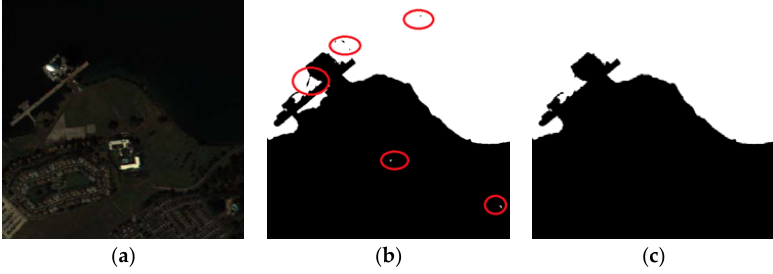
Figure 2. Land-sea segmentation based on multi-spectral fusion. ( a ) Multi-spectral original image; ( b ) land-sea segmentation; and ( c ) hole filling.